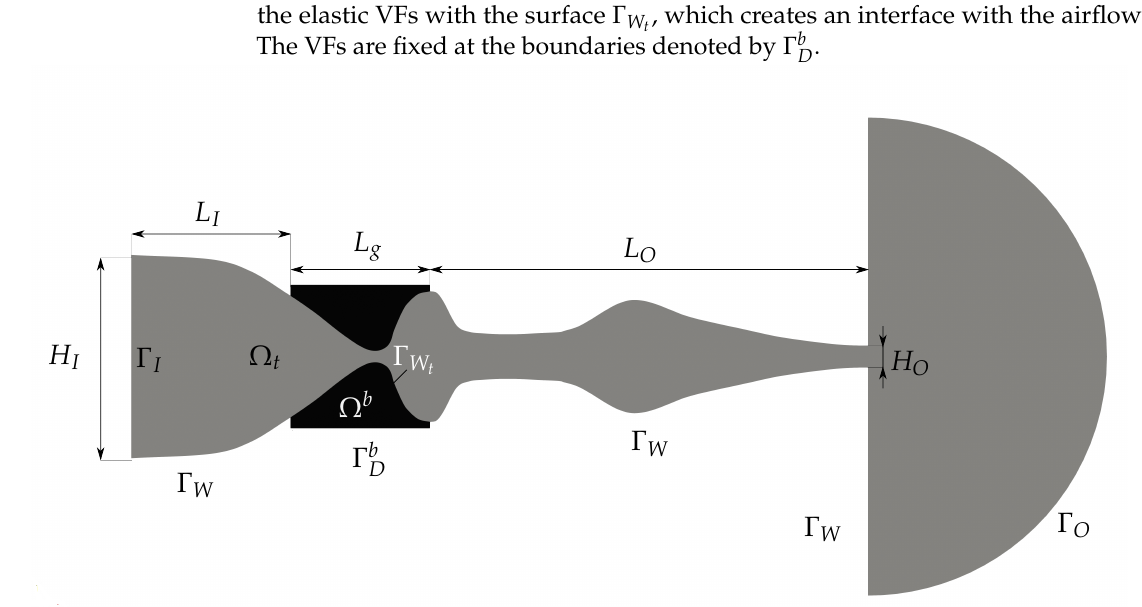
Figure 2. Computational domain at time t = 0: L I = 20.0 mm, L g = 17.5 mm, L O = 55.0 mm, H I = 25.5 mm, H O = 2.76 mm. The radius of the semicircle subdomain is 3.0 cm.